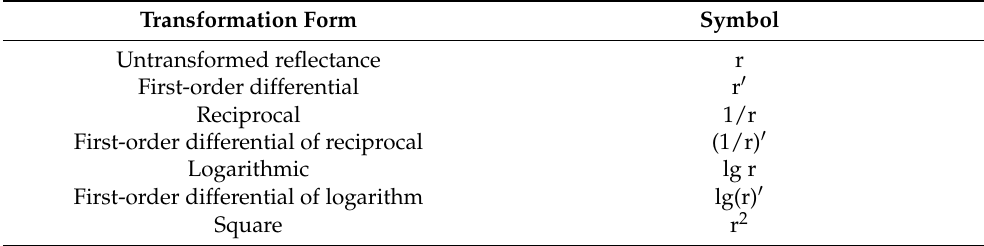
Table 1. Mathematical transformation form of hyperspectral